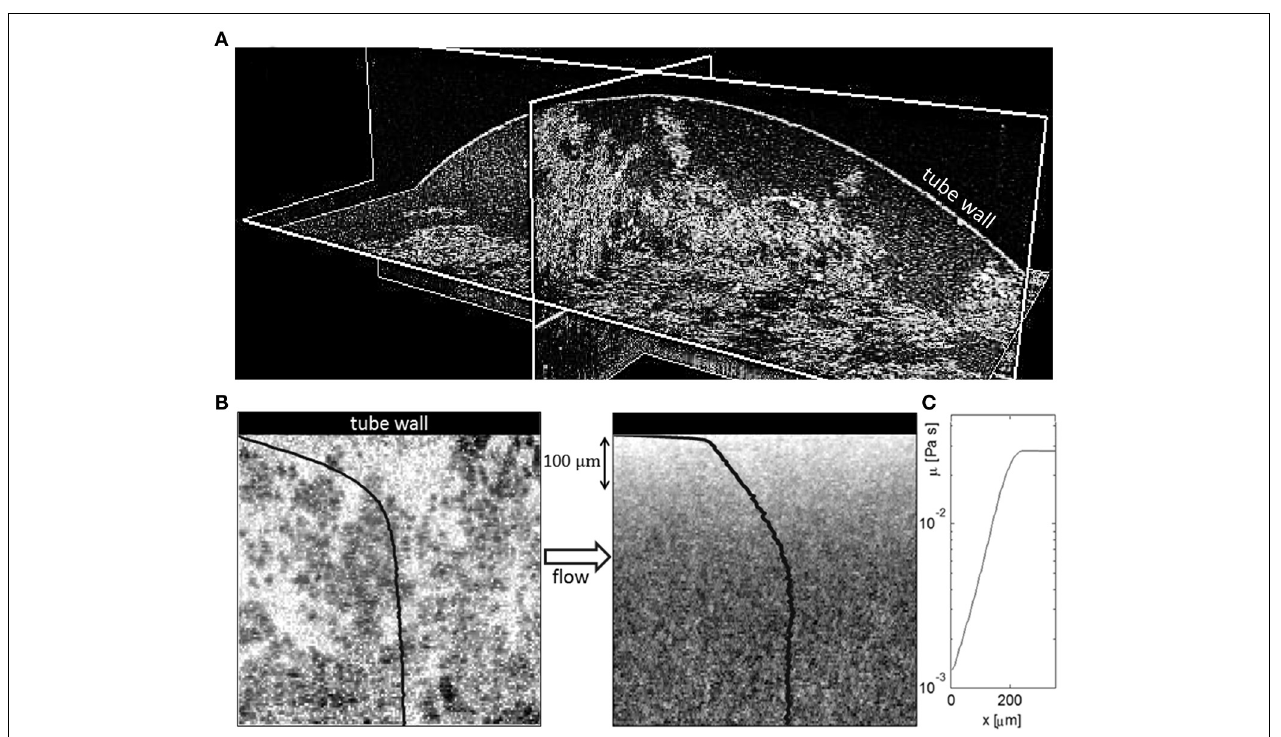
FIGURE 2 | (A) 3D OCT image of MFC suspension in a pipe with diameter of 8.6mm. Fiber-poor regions are clearly visible close to the pipe wall (curved surface). (B) 2D OCT image of flowing MFC (0.4%) suspension near the tube wall. Shown are an instantaneous image (left) and an average of 200 independent images (right) acquired with SD-OCT. The gray-scale values in the image represent the local value of the optical back-scattering index, light color